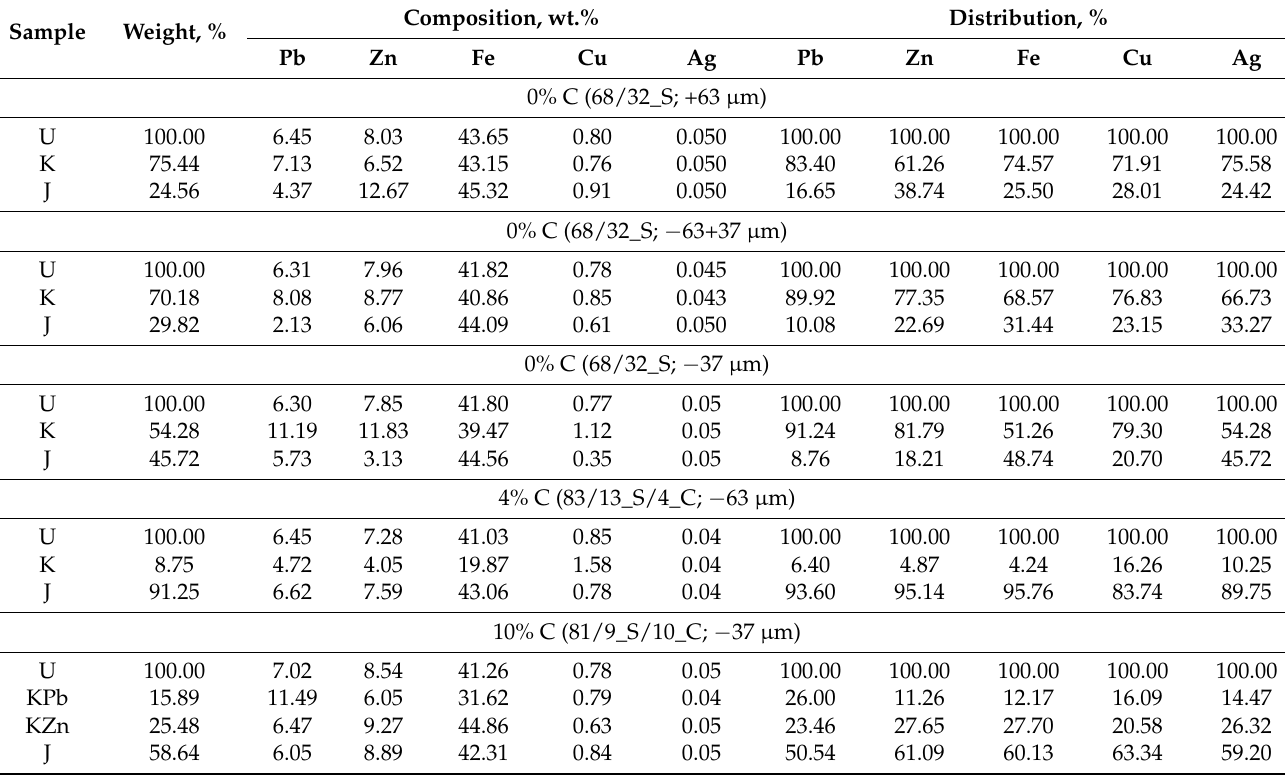
Table 7. Results of flotation tests (U-input material, K-concentrate,